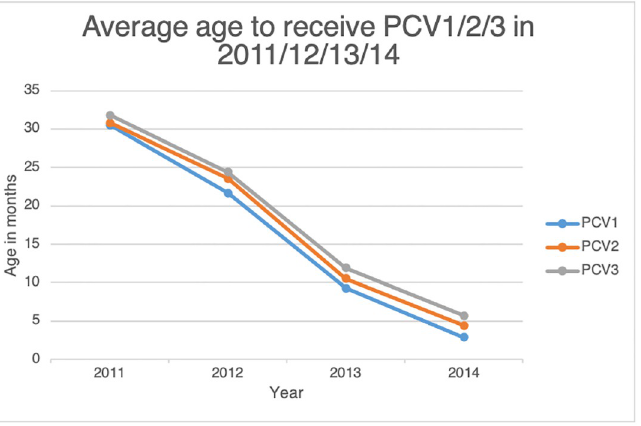
Fig 2. Demonstrating a child’s average age in months to receive PCV/1/2/3 since introduction in 2011 and survey completion in